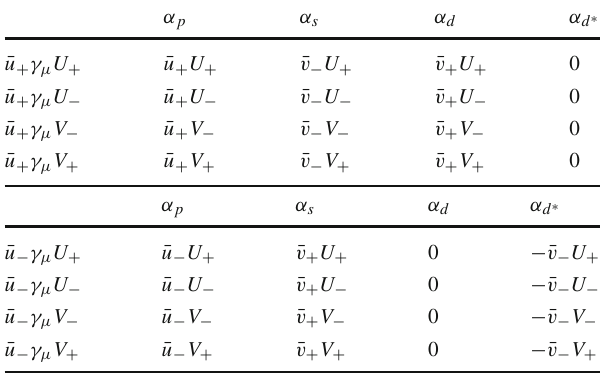
Table 1 Expansion coefficients according to Eq. (35)